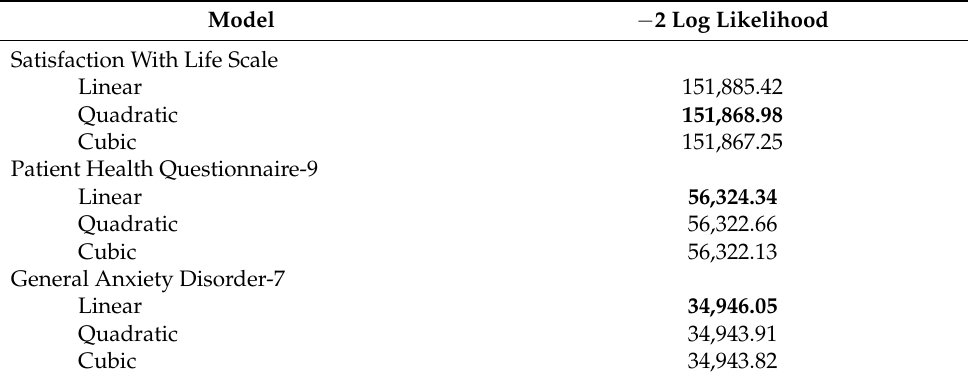
Table 3. Curvature model comparisons for SWLS, PHQ-9, and GAD-7 trajectories.